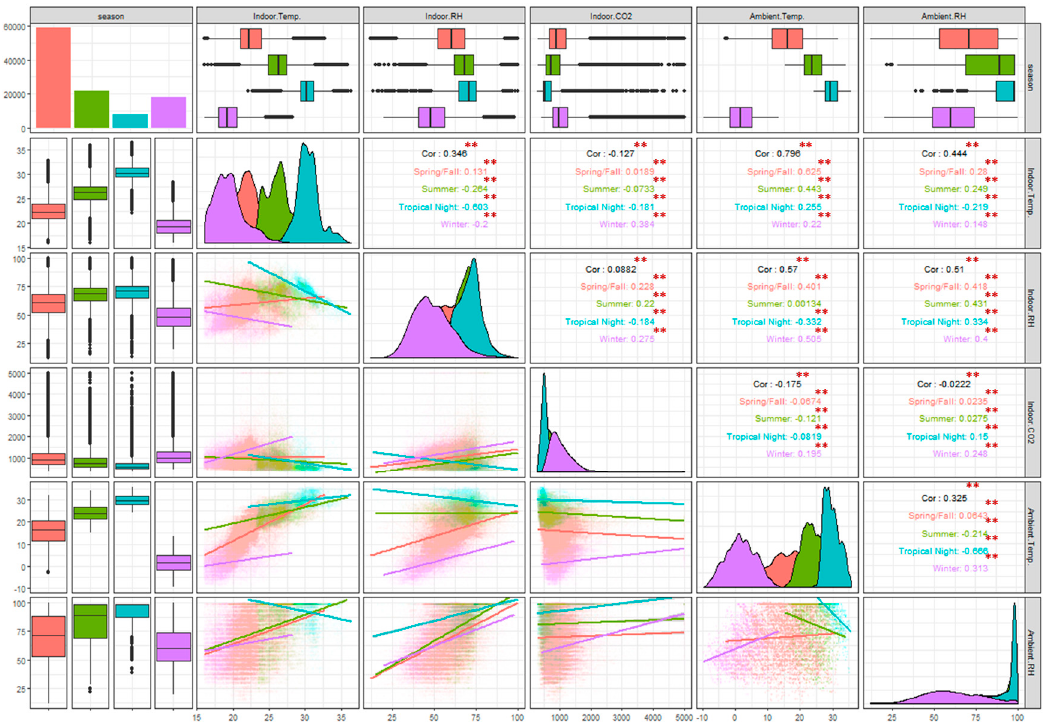
Figure 1. Correlations using scatter plots and regression results for indoor and ambient temperature, relative humidity, and CO 2 in apartments from March 2016 to March 2017, Seoul, South Korea. ** p < 0.05.